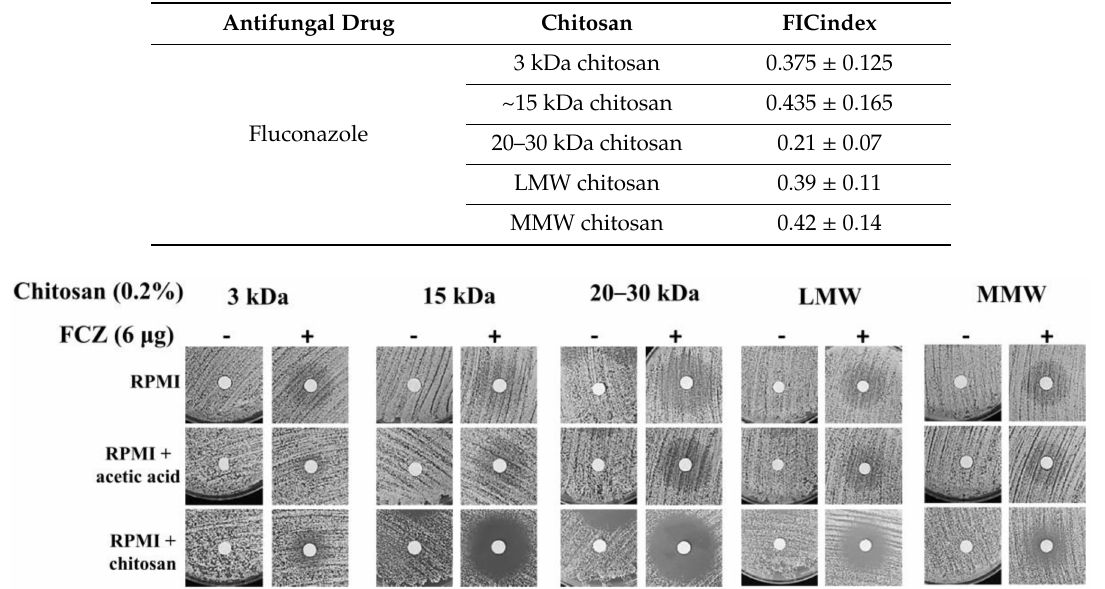
Figure 2. Disk di ff usion assay of each chitosan with or without fluconazole against C. tropicalis MYA3404. Di ff erent MWs of chitosan (except 3 kDa chitosan) with fluconazole exhibited great cytocidal e ff ects on C. tropicalis